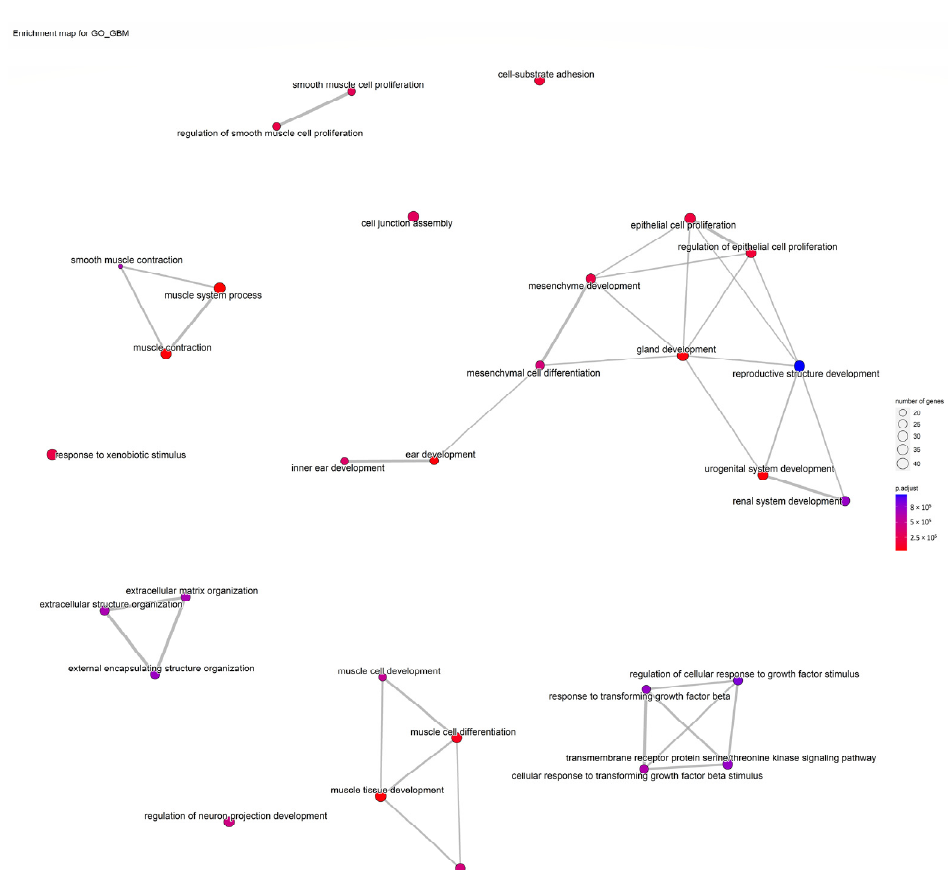
Figure 10. A network of GO terms.